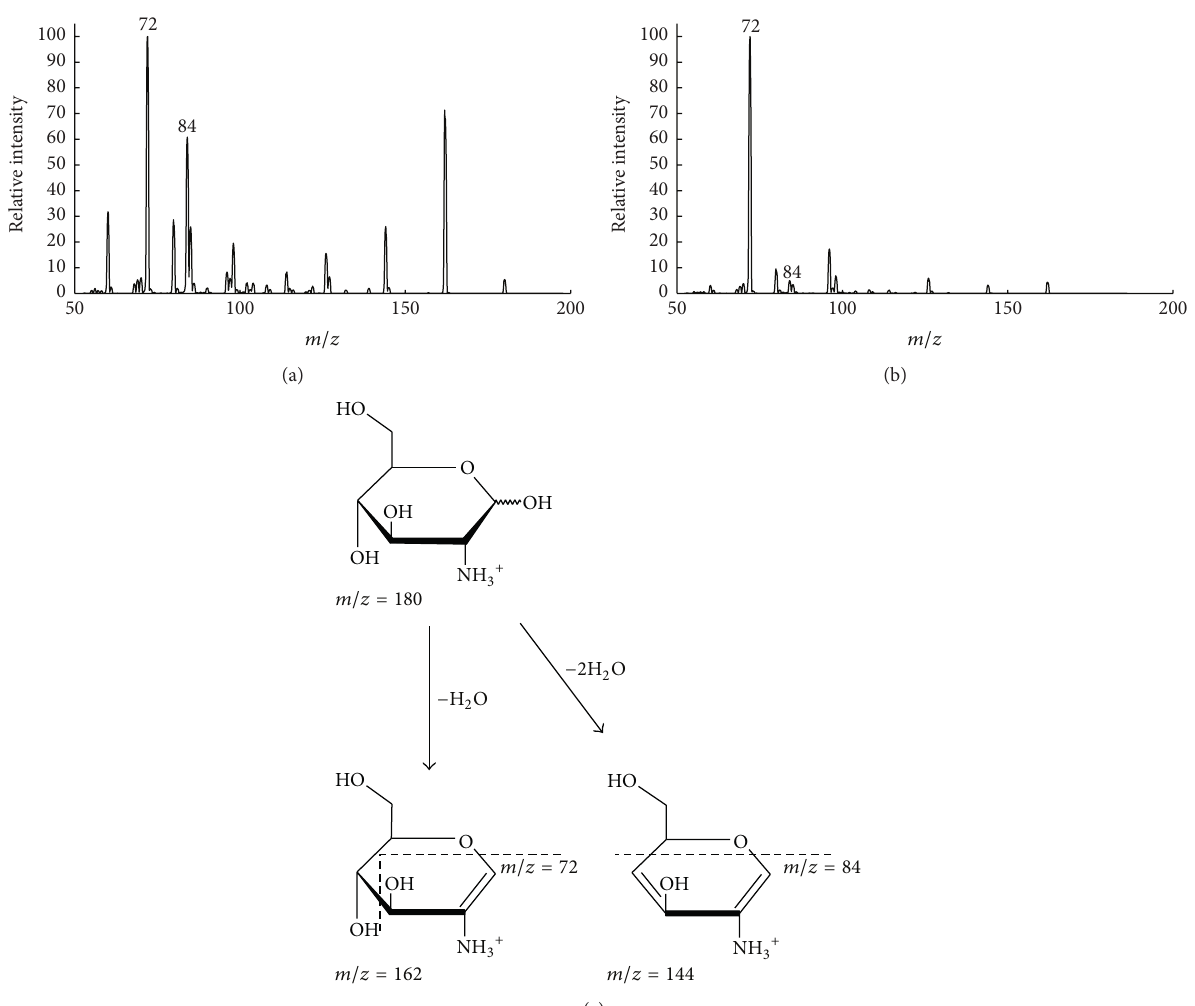
Figure 2: Positive ESI-MS/MS product ion spectra of (a) glucosamine and (b) galactosamine, produced through direct infusion of 100 𝜇 M reference solutions of each analyte with a collision energy of 25 V. Suggested fragmentation of glucosamine (c) presenting the formation of the two m/z transitions investigated in the method (180 → 72 and 180 → 84). Fragmentation of galactosamine is believed to follow the same route but with less formation of the 84 fragment due to the conformation of the C4 hydroxy